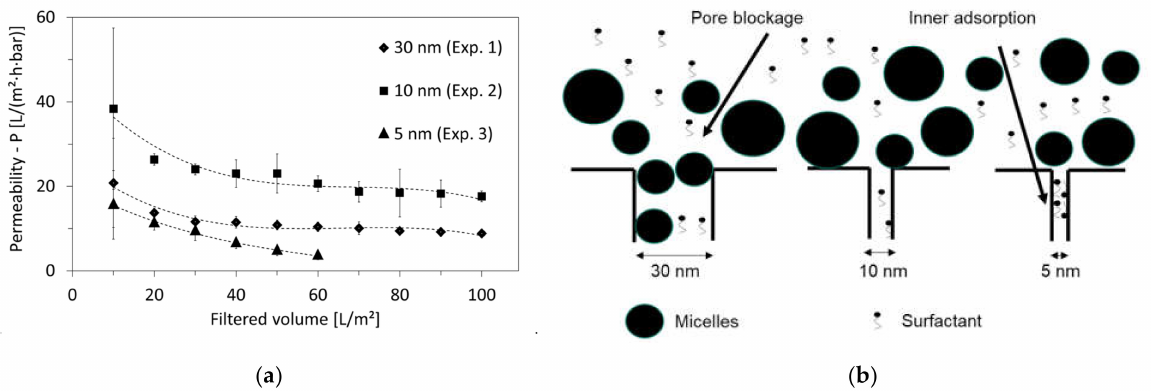
Figure 6. ( a ) Comparison of permeability of experiments performed using the membrane-pore sizes of 30 nm (experiment 1), 10 nm (experiment 2) and 5 nm (experiment 3) (applied TMP is 70 mbar for membrane-pore sizes of 30 and 10 nm and 100 mbar for the membrane-pore size of 5 nm) and ( b ) assumed pore blockage by micelle and (mainly cationic and non-ionic) surfactant adsorption on the inner walls of membrane